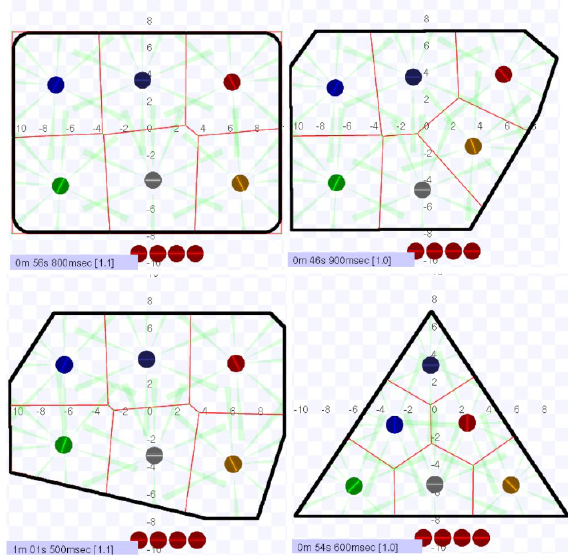
Figure 13: Border shape influence study final